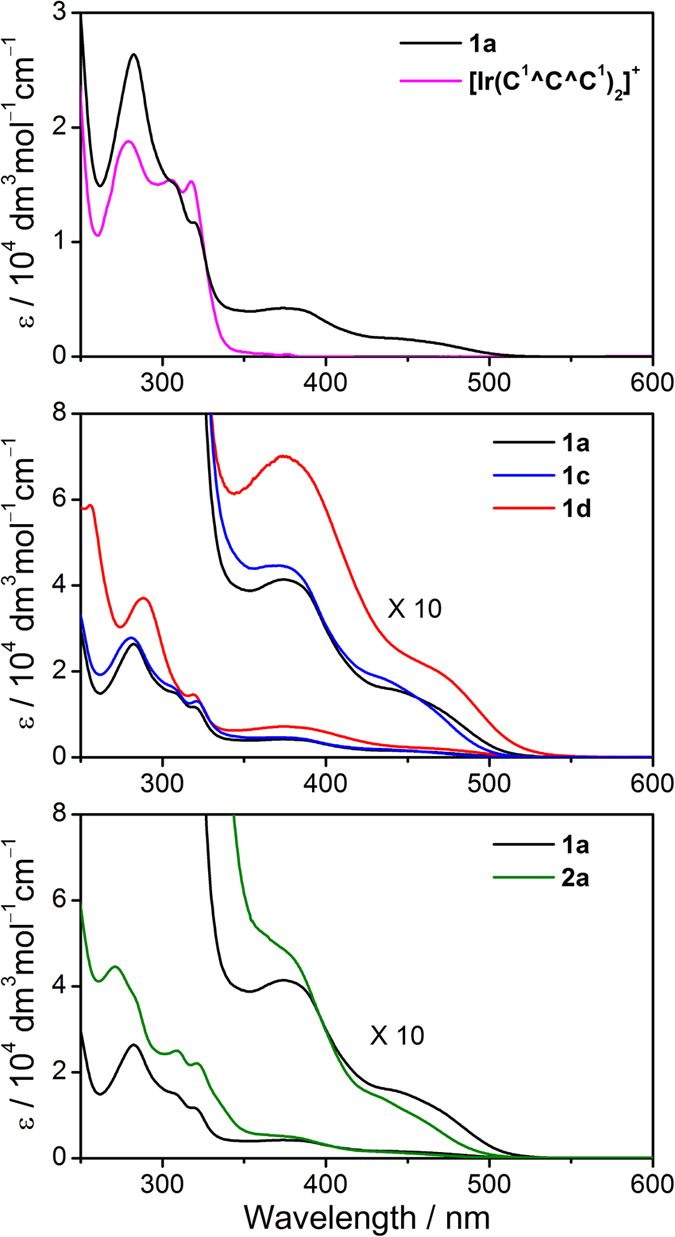
UV–visible absorption spectra of selected complexes in CH3CN at 298 K.